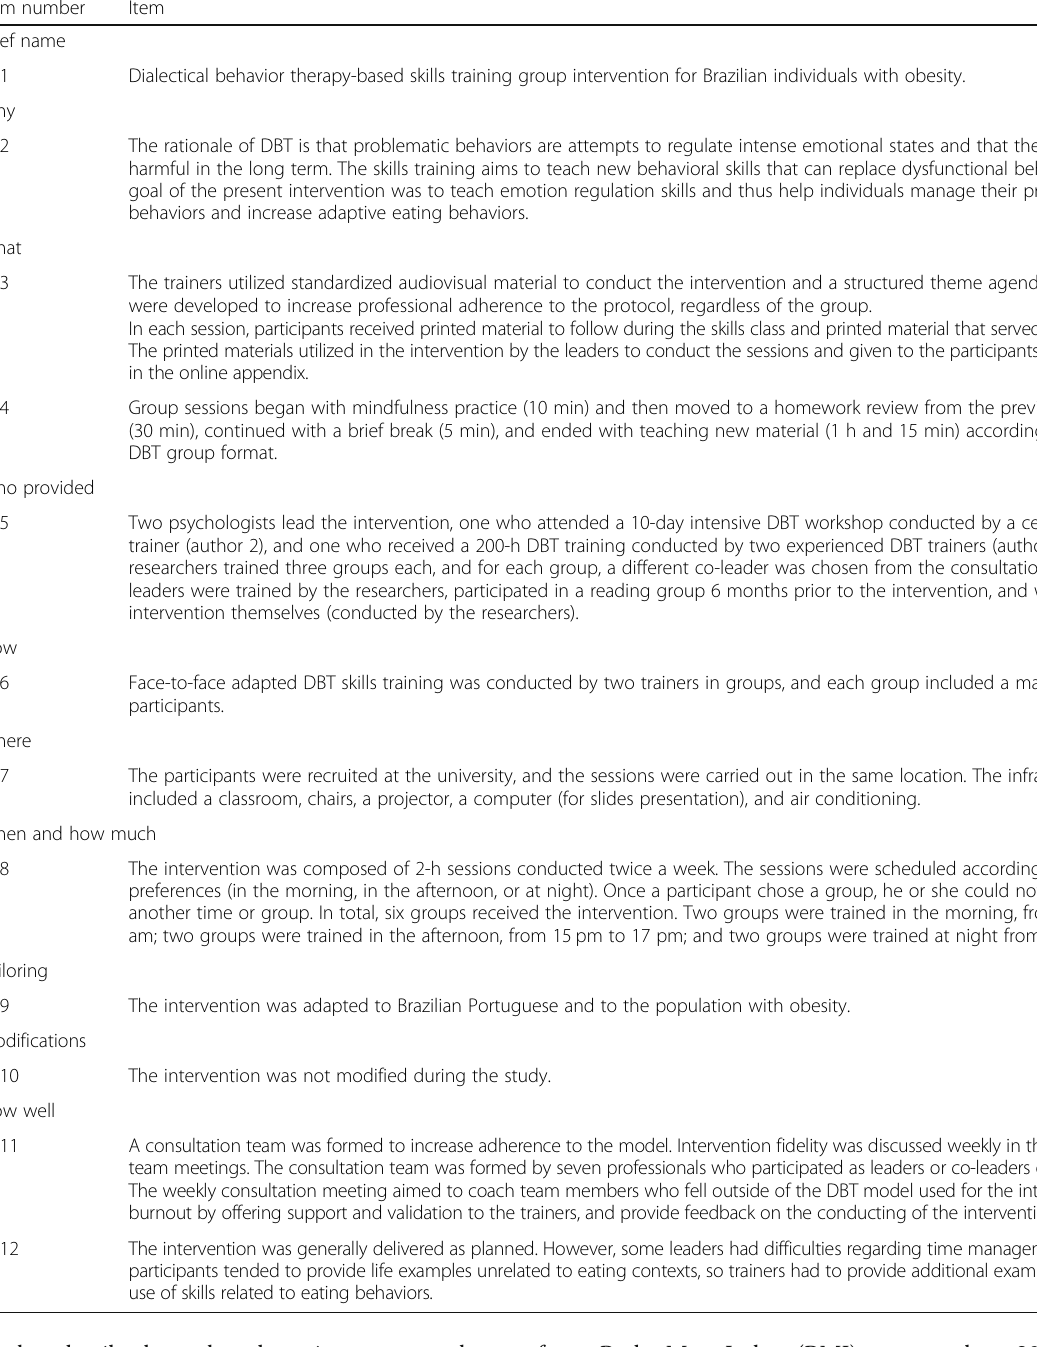
Table 1 Intervention description and replication (TIDieR)